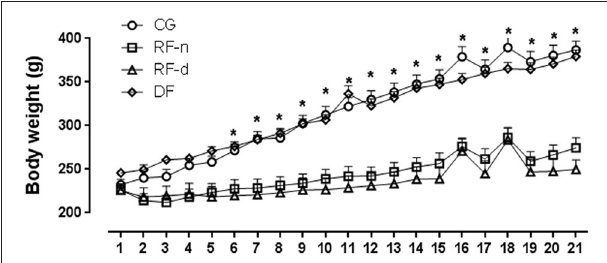
FIGURE 1 | Evolution of the body weight from Day 0–21 in the control group (circles) with food ad libitum , restricted night-fed group (RF-night, squares) with access to food restricted to ZT12 to ZT14 (1800–2000h), restricted day-fed group (RF-day, triangles) with access to food restricted to ZT3 to ZT5 (0900–1100h) and, restricted day-fed group (DF, diamonds) with access to food restricted to ZT0 to ZT12 (0600–1800h). N = 6–10 rats per time point per group. ZT, Zeitgeber Time. Significant difference among ZTs within the same feeding condition: * P <